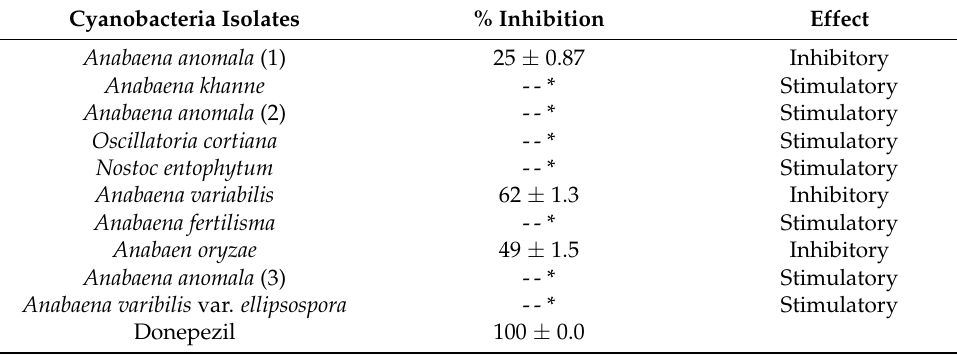
Table 2. AChE inhibition % in the presence of tested cyanobacteria crude extracts. Cyanobacteria